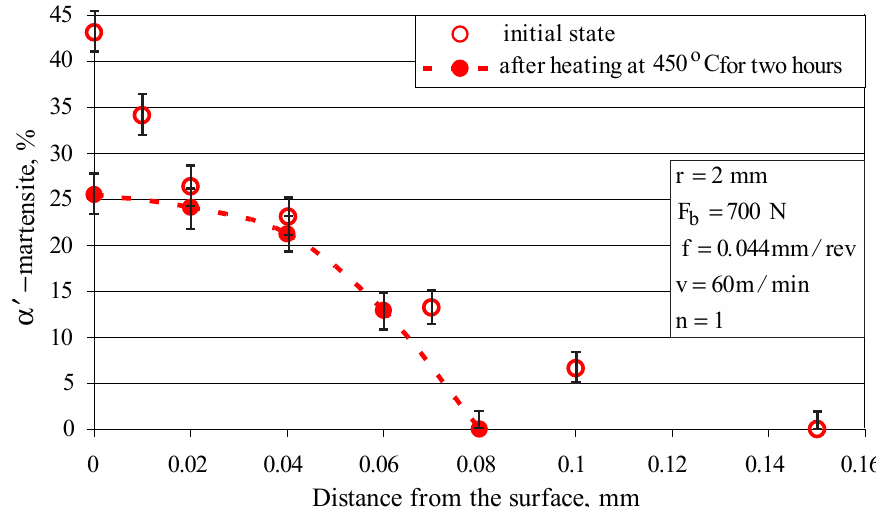
Figure 18. Reverse martensitic transformation due to heating.